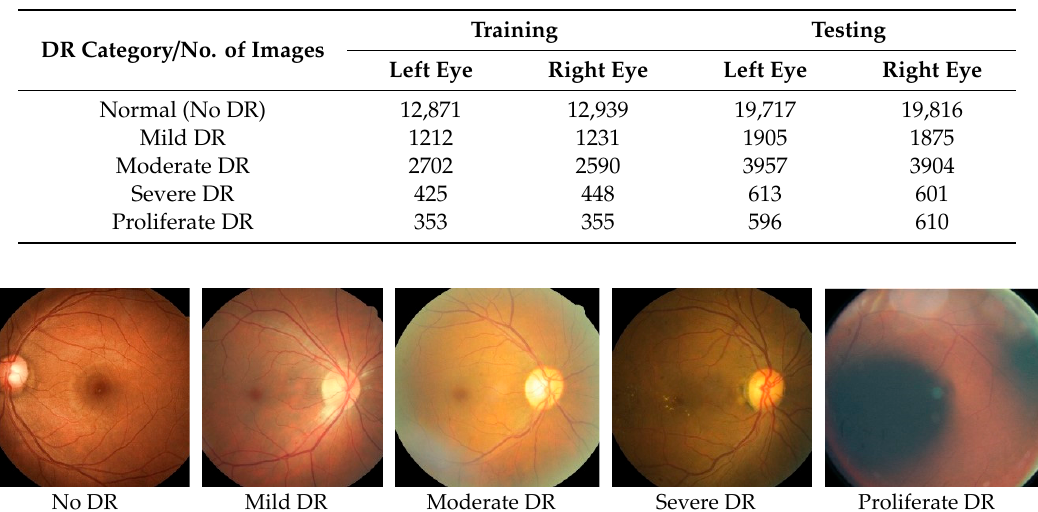
Figure 1. Sample images from the five different image classes showing various DR stages: No DR, Mild DR, Moderate DR, Severe DR, and Proliferate DR. As the disease progresses, blood vessels expand, slowly distorting vision over time.